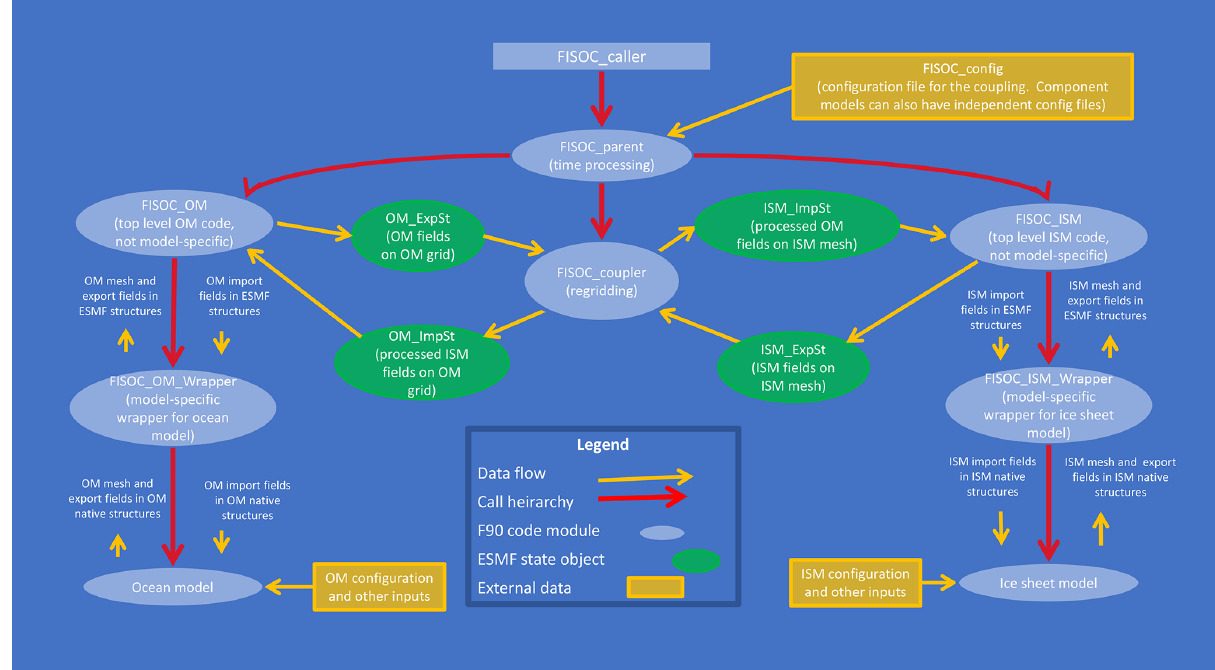
Figure 1. Overview of FISOC code structures. OM and ISM are short for ocean model and ice sheet model (or component), respectively. ImpSt and ExpSt are short for import state and export state, respectively. Table 2. Model choices and input parameters used in verification experiment 1 (VE1, Sect. 3.1) and verification experiment 2 (VE2, Sect. 3.2) comprising four simulations in total: VE1_ER, VE1_EF, VE2_ER and VE2_EF. Component abbreviations in these simulation names are E (Elmer/Ice), R (ROMS), and F (FVCOM). Semi-structured refers to a mesh that is in principle unstructured but where in practice a structure can be seen (see Fig. 3 middle and lower panels). STOD stands for source to